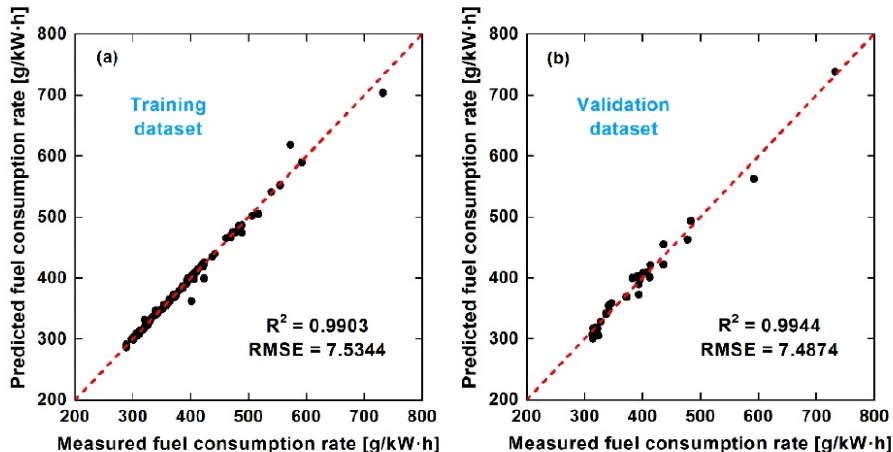
Figure 5. Comparison of SVR predicted results with measured data of fuel consumption. ( a ) Training dataset; ( b ) Validation dataset.